Question: Which kind of chart has been used to present this data?
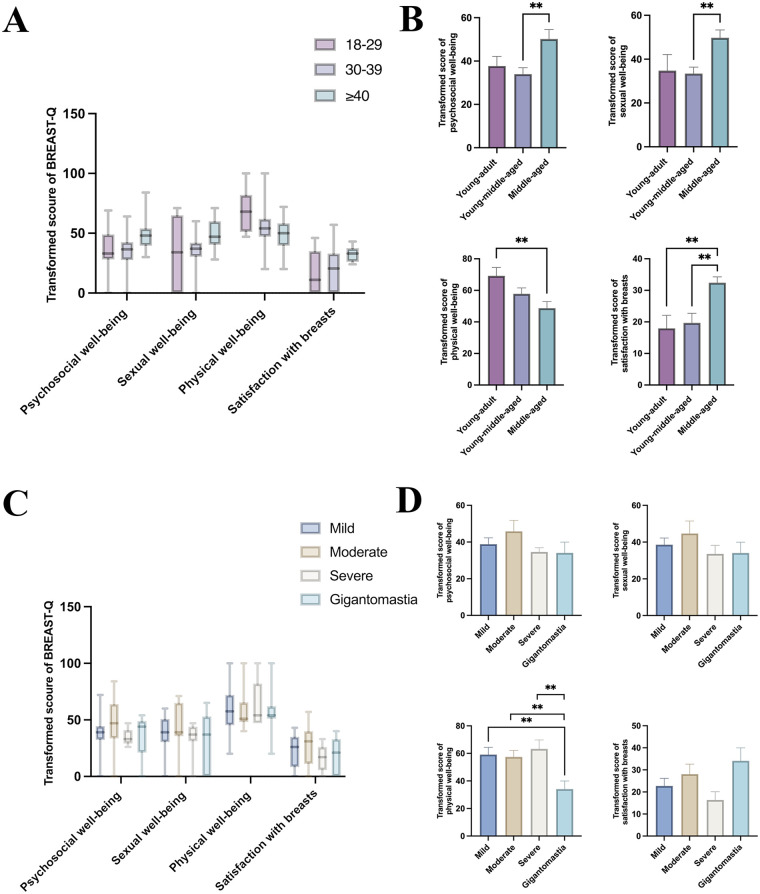
Answer: box